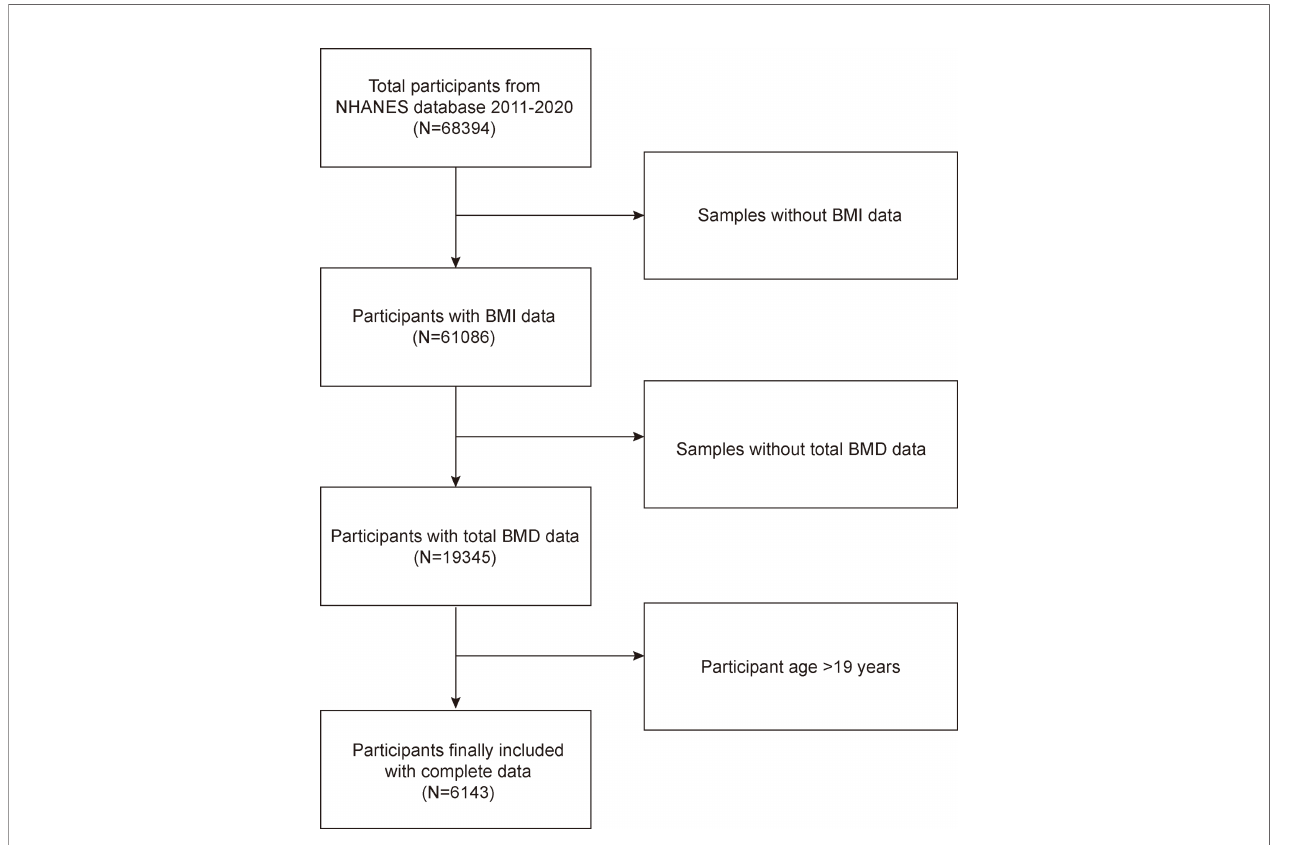
FIGURE 1 | Flow chart of participants selection. NHANES, National Health and Nutrition Examination Survey; BMD, bone mineral density; Body Mass Index,